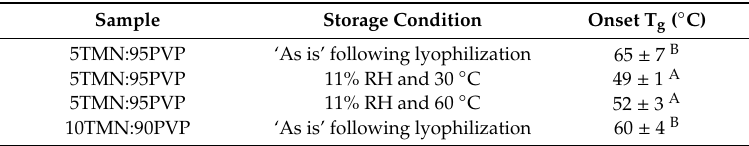
Table 1. Onset glass transition temperatures of TMN:PVP solid dispersions after lyophilization and equilibration at 11% RH and 30 or 60 ◦ C. Superscript letters denote statistical significance. Sample Storage